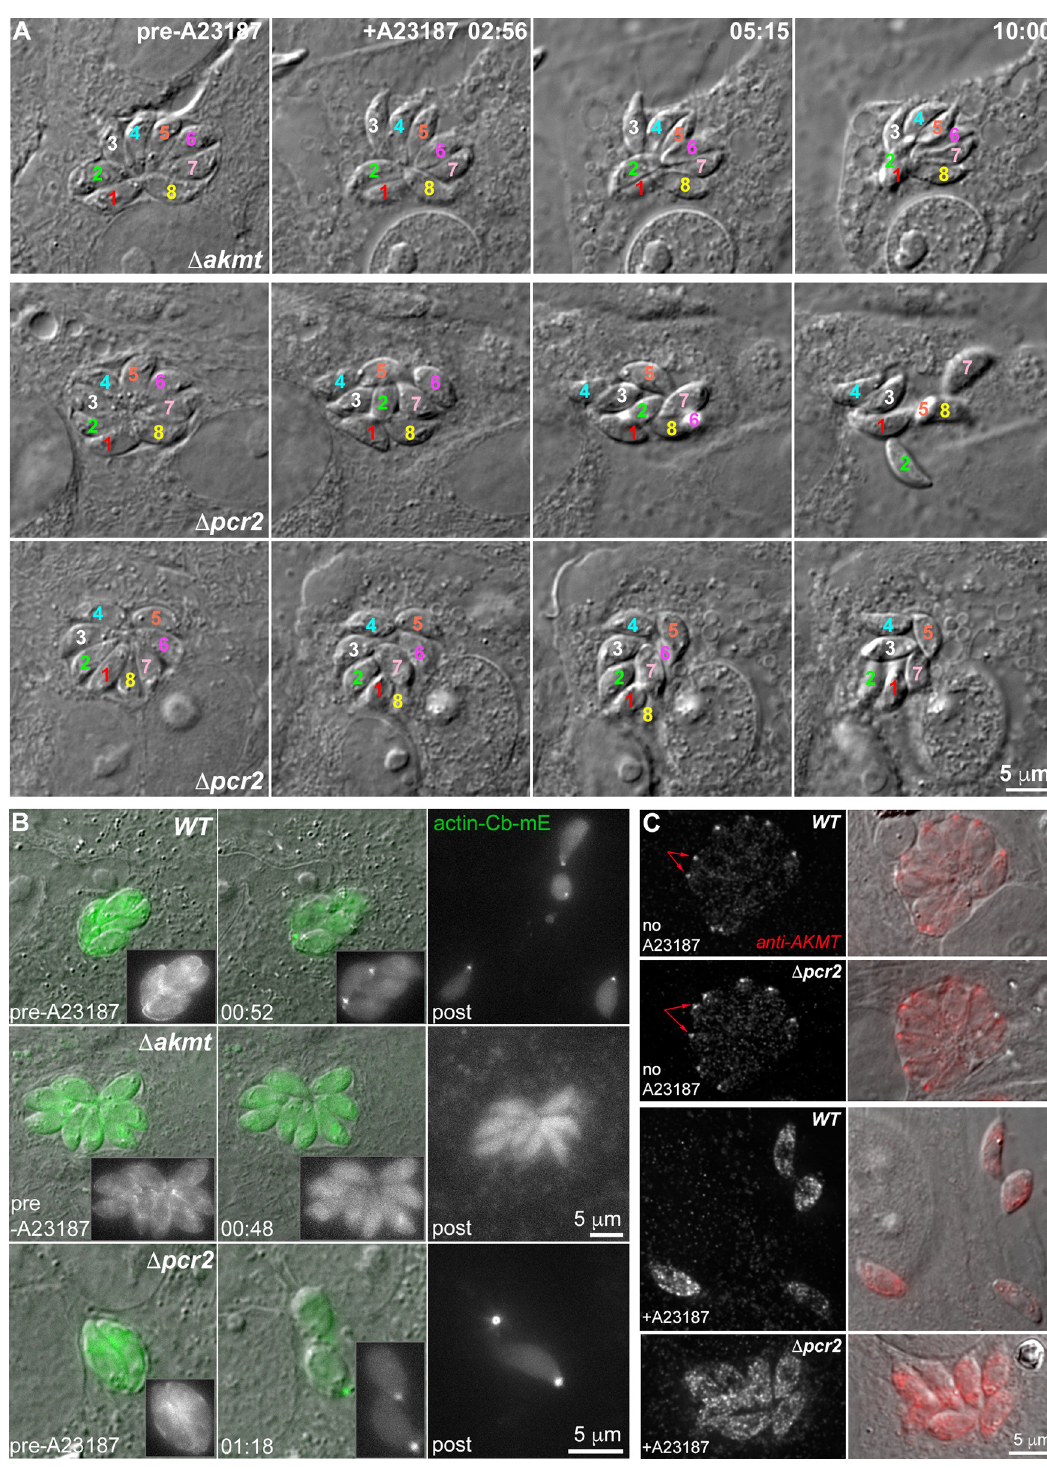
Fig 8. Pcr2 functions differently from another motility regulator, AKMT, and Pcr2 knockout does not block actomyosin activity. A. Images selected from time-lapse experiments of intracellular Δ akmt and Δ pcr2 parasites treated with 5 μ M A23187. Note that Δ akmt parasites, which are largely immobile, maintained their organization within the vacuole after lysis of the host cell. However the position and orientation of the Δ pcr2 parasites shifted during the time lapse due to sporadic parasite movement (see S4 Video). B. Actin-chromobody-mEmerald (actin-Cb-mE) distribution before and after A23187 treatment in RH Δ hx Δ ku80 parental